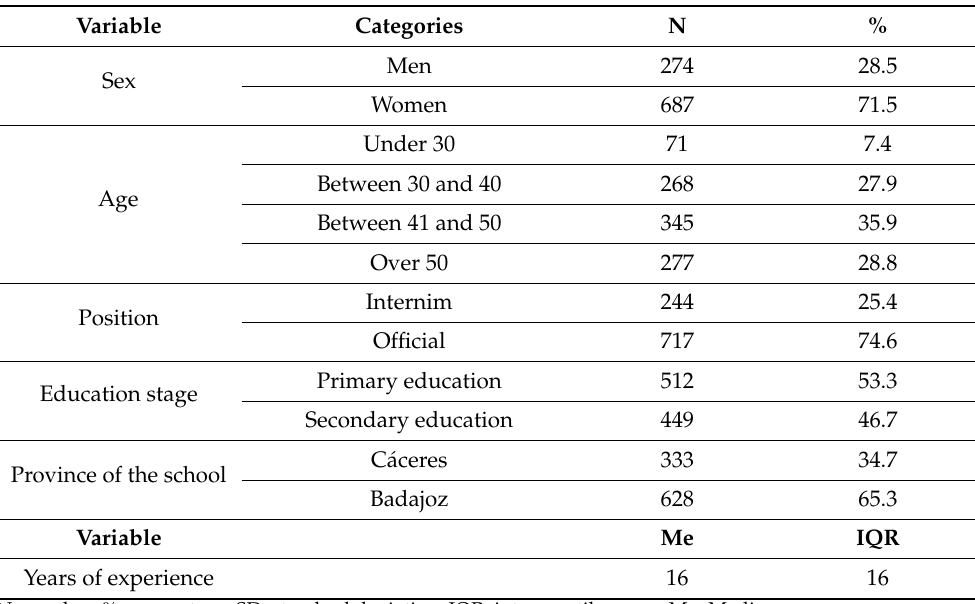
Table 1. The sociodemographic characterization of the